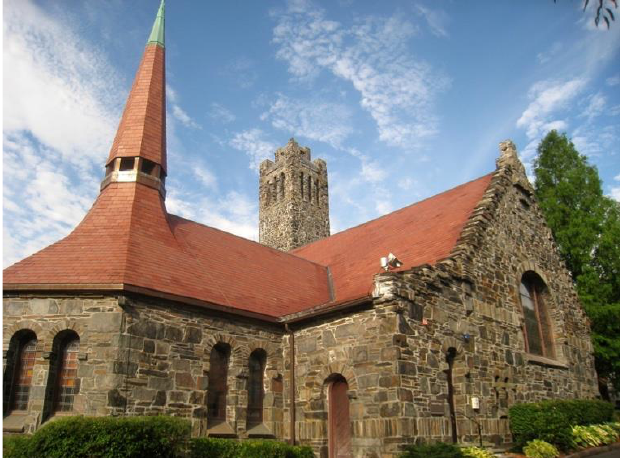
Figure 7. Exterior of Goddard Chapel at Tufts.